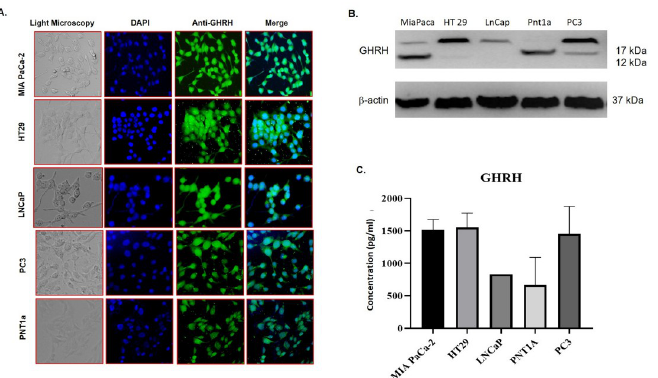
Fig 5. Demonstration of GHRH expression in different cancer cell lines. A GHRH expression was figured out in MIA PaCa-2 pancreatic cancer, HT-29 colorectal cancer, PC3 prostate cancer, and PNT1a normal prostate epithelium cell lines by immunofluorescence. DAPI was used to observe the nuclei of the cells. B Translational expression of GHRH in MIA PaCa-2, HT-29, PC3, and PNT1a cells was determined by immunoblotting. ß-actin was used as a loading control. C. GHRH concentrations in media of MIA PaCa-2, HT-29, PC3, and PNT1a cells determined by Human GHRH ELISA.